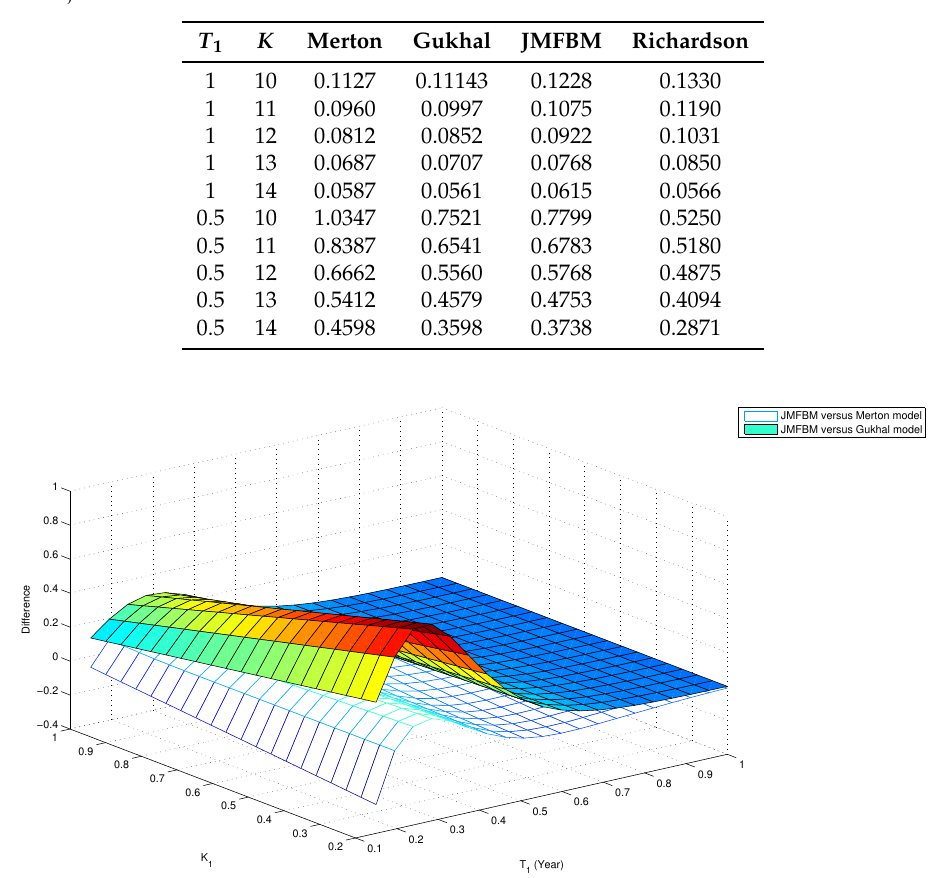
Table 1. Results by different pricing models. Here, r = 0.1, σ = 0.1, L = 5, M = 15, A =0.05, H = 0.8, S = 12, σ J = 0.3, k = − 0.004.